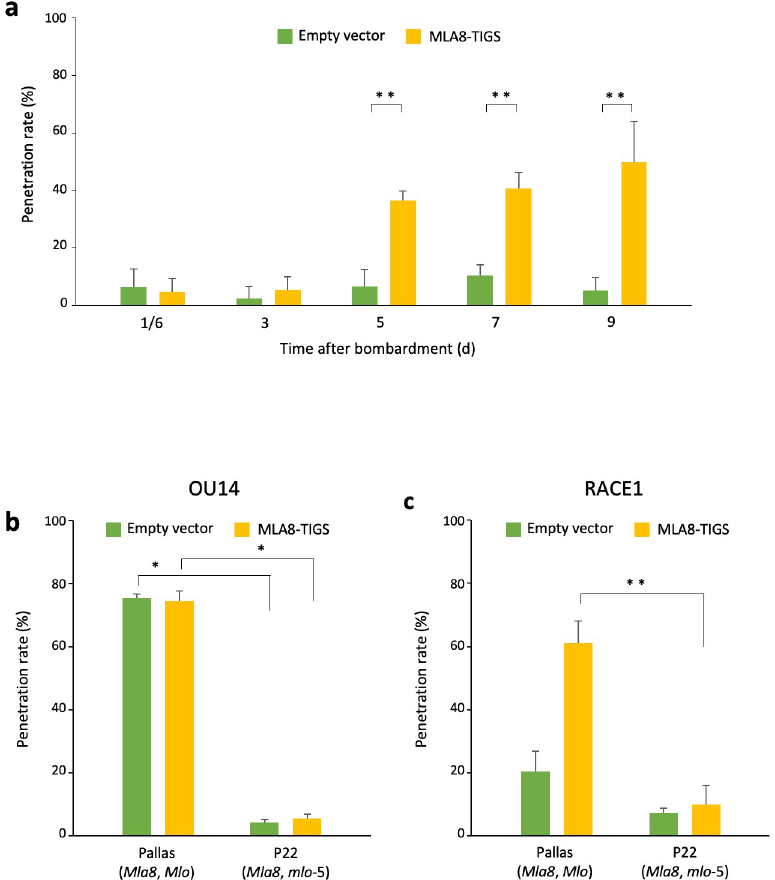
Fig 4. RACE1 was not able to overcome the penetration resistance conferred by the mlo -5 mutation. ( a ) Penetration rate of RACE1 increased from 5 days after the introduction of MLA8-TIGS construct in Pallas ( Mla8 ) epidermal cells. Penetration rates of OU14 ( b ) and RACE1 ( c ) were examined in MLA8-TIGS-introduced epidermal cells of Pallas and P22 ( mlo -5). The empty pANDA-mini vector was introduced as a negative control. Error bars represent standard deviation (n = 3). The mean values of these experiments were calculated from independent experimental data obtained from 2–10 introduced leaves. � , P < 0.05; �� , P < 0.01 (Student’s t -test).